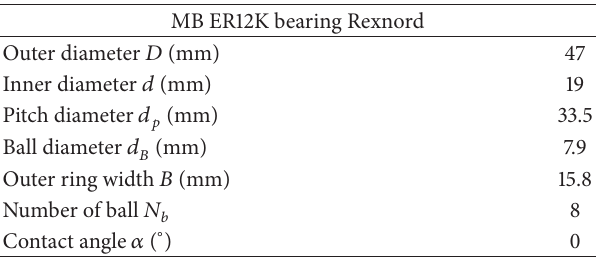
Table 2: Specifications of the test’s rig bearings.